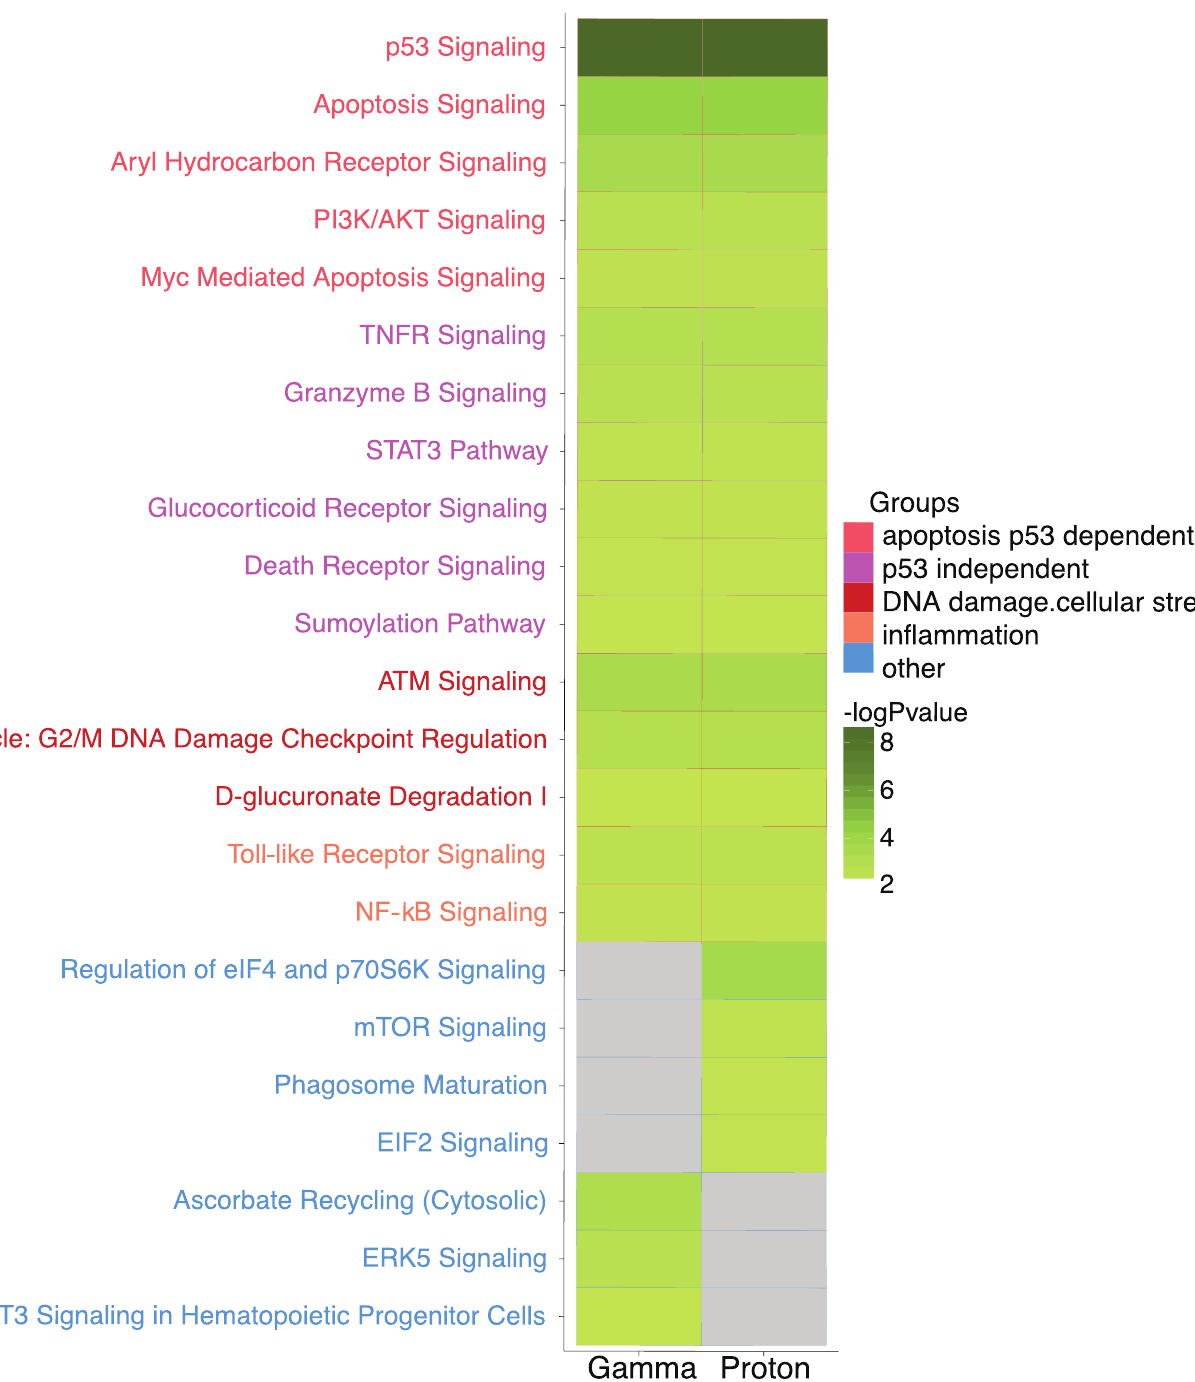
Fig 6. Pathway analysis. Common canonical pathways enriched by genes that present a dose-dependent increase expression in response to gamma and proton radiation. (log p -value < 2 is interpreted as no enrichment; grey color).